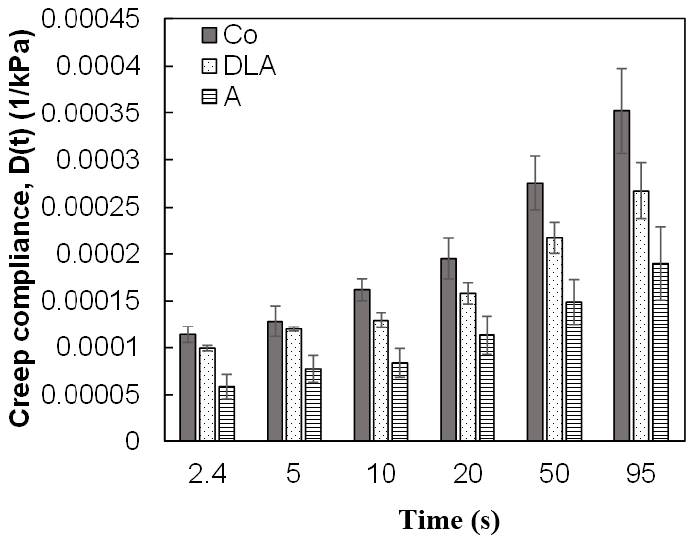
Figure 10. Creep compliance data for Co, A, and DLA samples at 2.4, 5, 10, 50, and 95 s3.4. Indirect Tensile Strength Test.